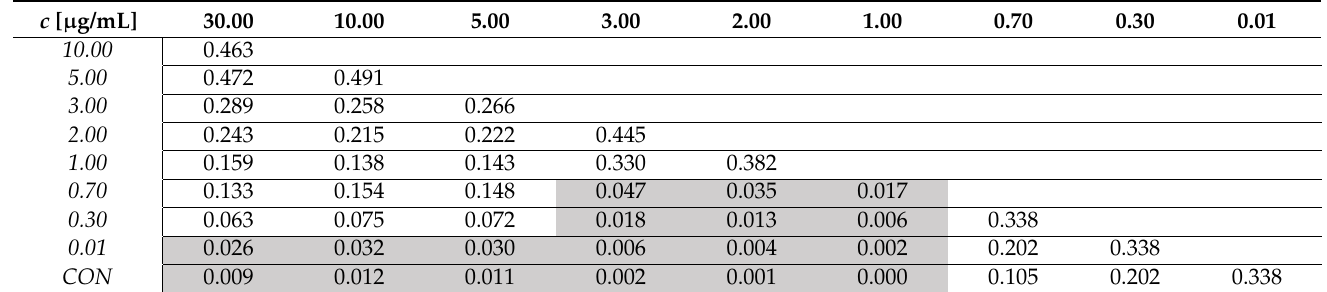
Table 3. Kruskal-Wallis post hoc Dunn test for comparison of mean metabolic activities in the presence of different concentrations of extract. The p values are reported in the table.